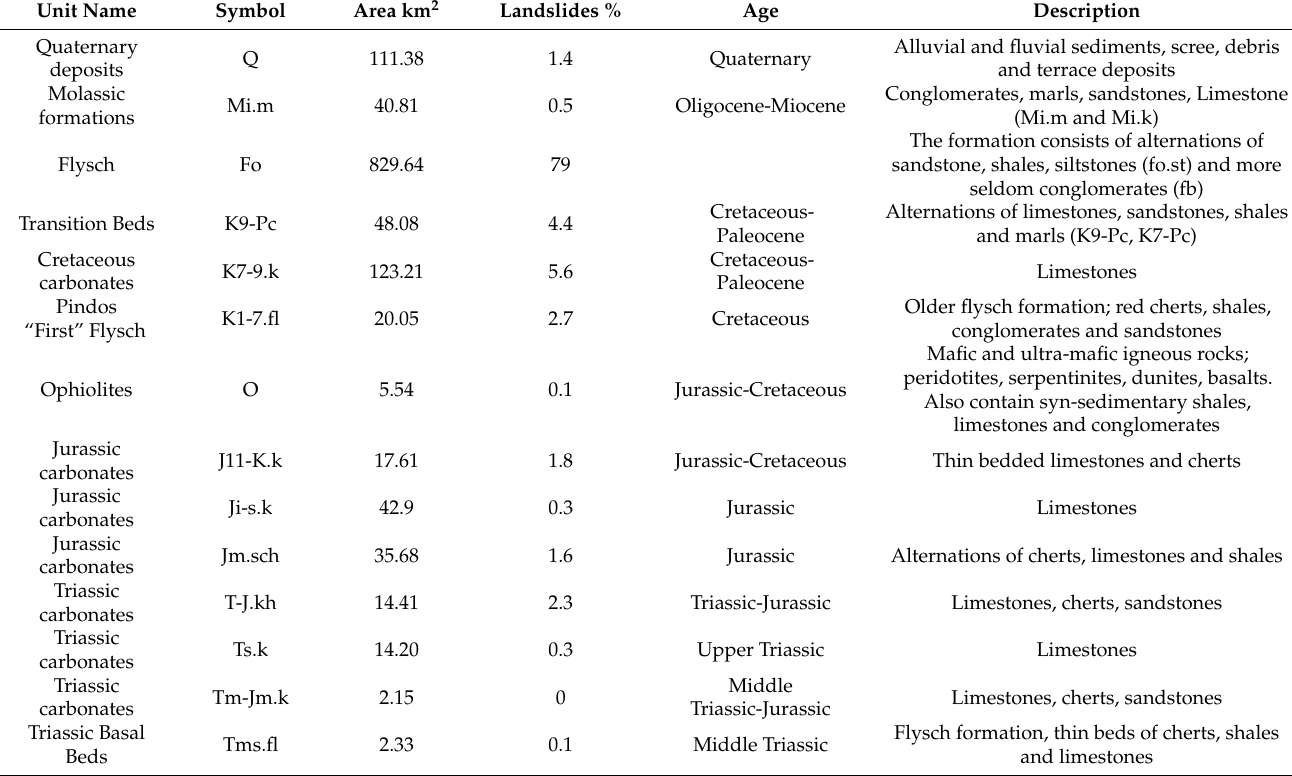
Table 1. Description of geological formations (based on